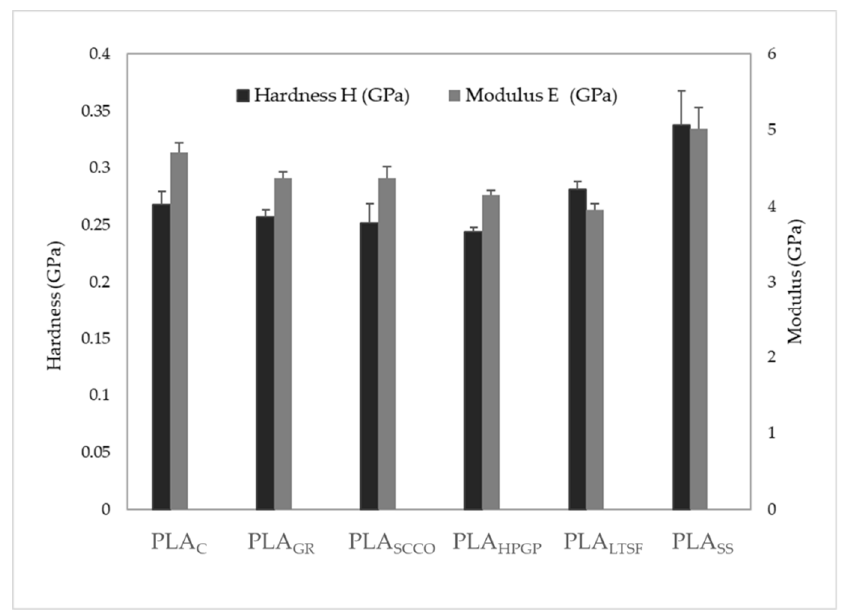
Figure 6. Modulus and hardness of PLA discs subjected to the different sterilisation treatments: PLA GR , PLA SCCO , PLA LTSF , PLA SS and PLA HPGP together with the untreated PLA disc as control, PLA C . Results are presented as mean ± standard deviation.